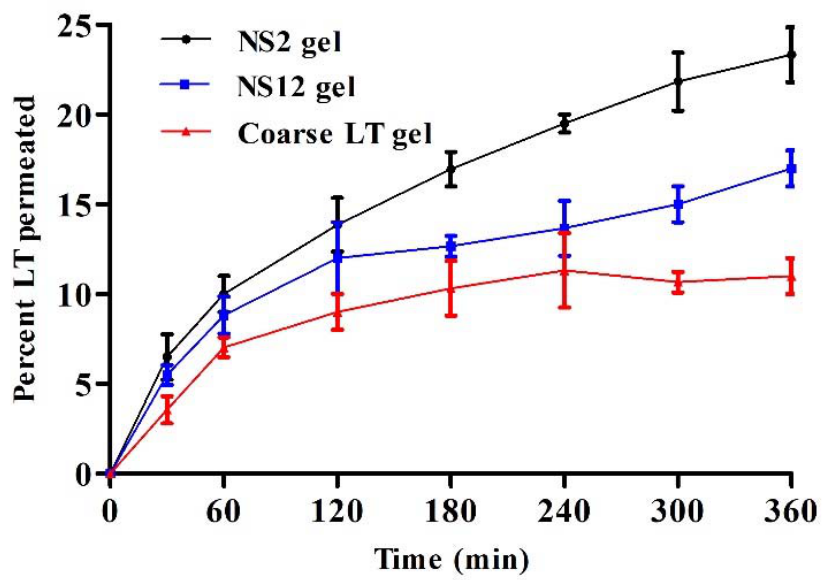
Figure 8. Ex vivo skin permeation of LT as a percentage through full-thickness skin samples versus time for NS2, NS12, and coarse LT gels (mean values ± SD, n = 3).